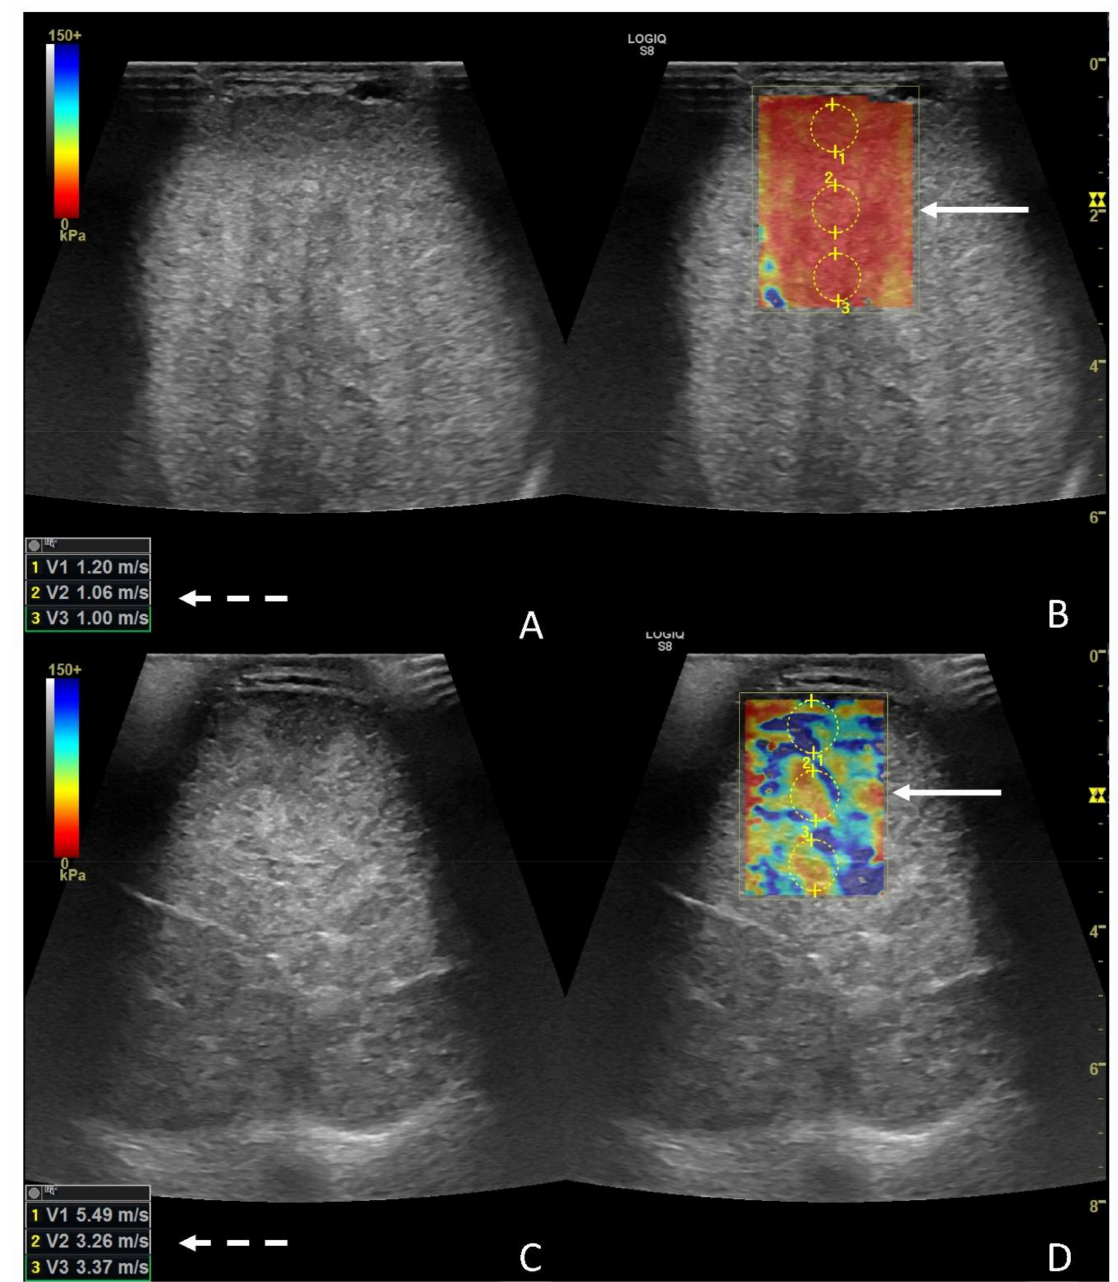
Figure 6. Images from 2D-SWE of a normal ( A , B ) and a diseased testicle ( C , D ). In panels A and B, the B-mode image and the elastogram are presented, respectively; the white dotted arrow points at the values from the ROIS manually drawn on the elastogram (white solid arrow). In panels C and D, a B-mode image and elastogram are presented as well; notice the higher values (white dotted arrow) from the ROIS pointed on the elastogram (white solid